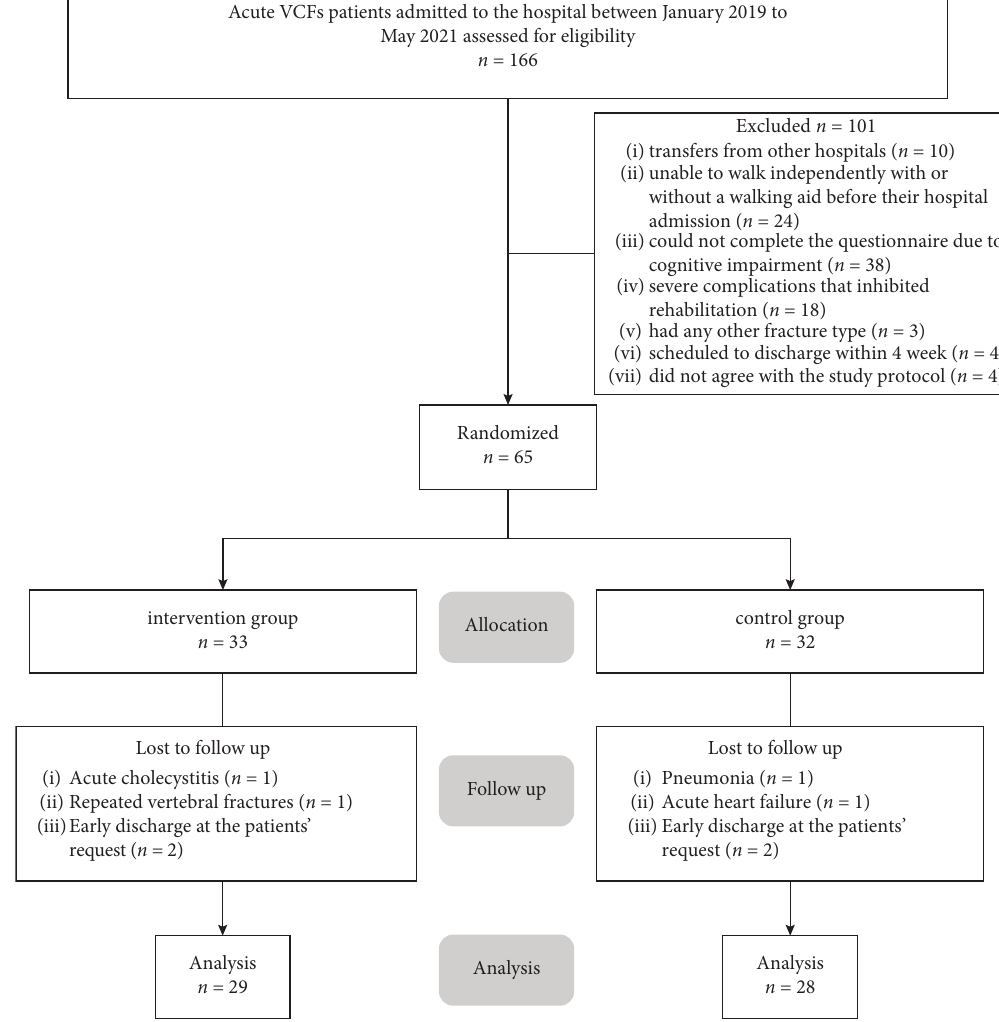
Figure 1: Te fow of participants in the randomized